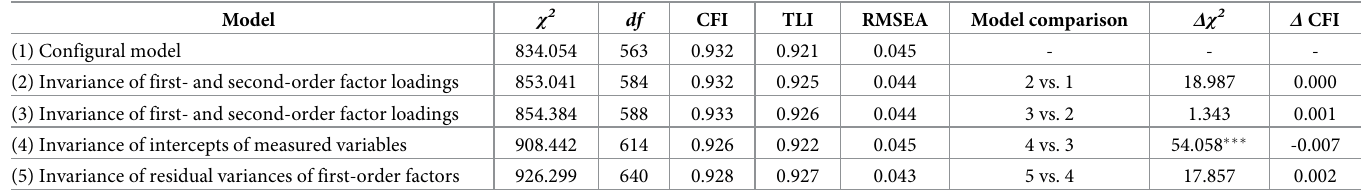
Table 2. Testing invariance of PYD scale structure by gender. Model Model comparison Δχ 2 Δ